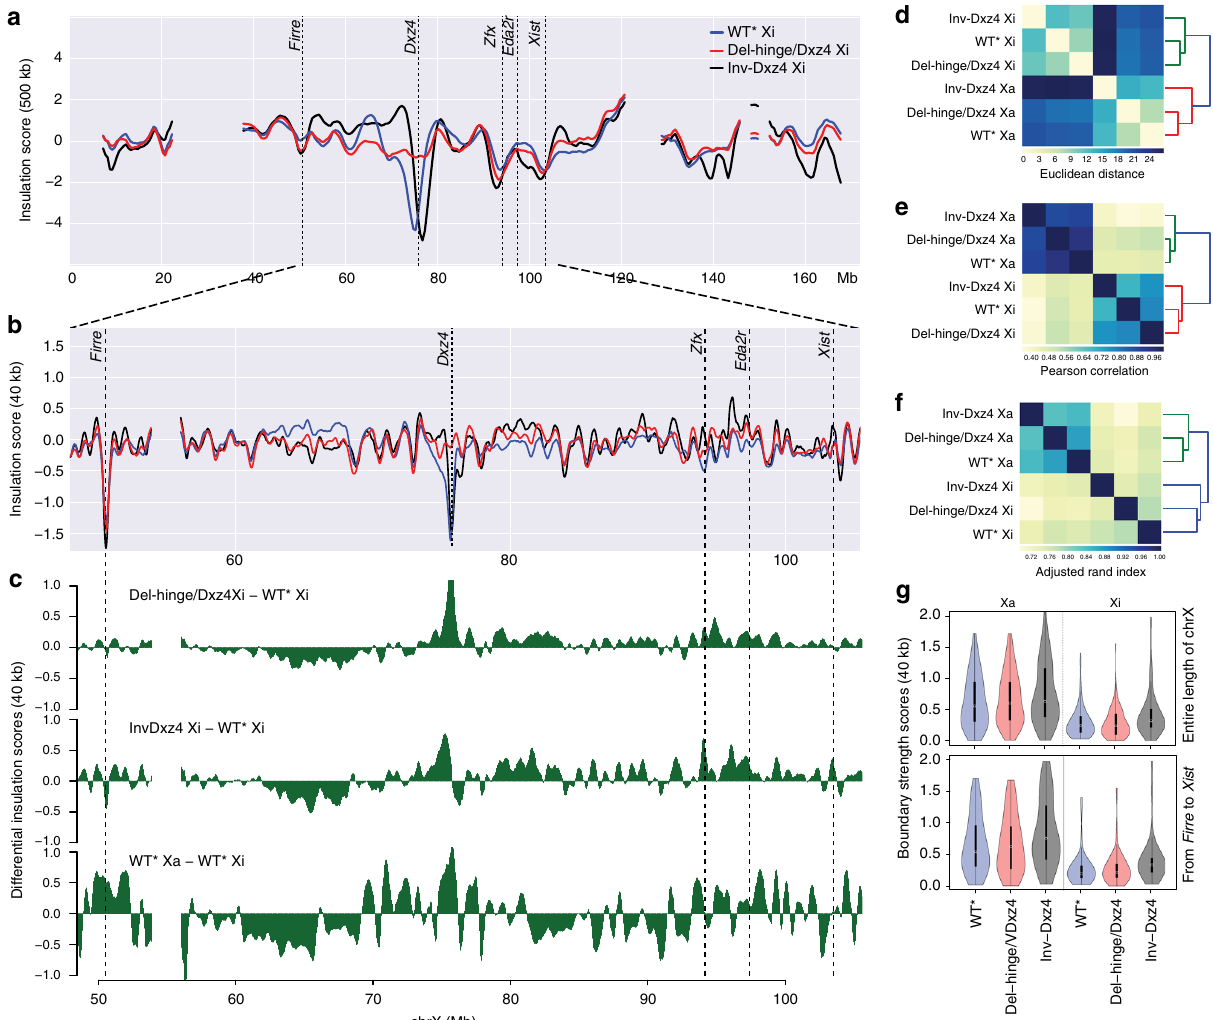
Fig. 4 Changes in Xi TAD con fi guration after Dxz4 deletion or inversion. a Insulation score pro fi les at 500 kb resolution for the whole Xi in WT* (blue), Del- hinge/Dxz4 (red), and Inv-Dxz4 (black). The positions of Firre , Dxz4 , Zfx , Eda2r , and Xist are indicated. See Supplementary Fig. 4e, f for analysis of insulation scores of Xi and Xa in all cell lines. b As in a but based on 40 kb resolution data for a region from Firre to Xist along the X chromosome. c Differential insulation score pro fi les for Del-hinge/Dxz4 Xi (top), Inv-Dxz4 Xi (middle), and WT* Xa (bottom) relative to WT* Xi based on 40 kb resolution data for a region from Firre to Xist . d , e Hierarchical clustering based on the Euclidean distance ( d ) and Pearson correlation (using 1 − r as the distance measure; e ) between standardized insulation scores at 40 kb resolution considering the Xi and Xa in WT*, Del-hinge/Dxz4, and Inv-Dxz4. See Supplementary Fig. 4g for analysis of all cell lines. f Hierarchical clustering based on the adjusted Rand index to quantify the correspondence between TADs called using insulation scores at 40 kb resolution along the Xi and Xa in WT*, Del-hinge/Dxz4, and Inv-Dxz4. g Violin plots showing the distributions of TAD boundary strength scores (see Methods) for the Xa (left) and Xi (right) in WT* (blue), Del-hinge/Dxz4 (pink), and Inv-Dxz4 (gray) for the entire X chromosome (top) and for the region from Firre to Xist (bottom). The boxes demarcate the interquartile range (IQR) with median. Whiskers are ±1.5